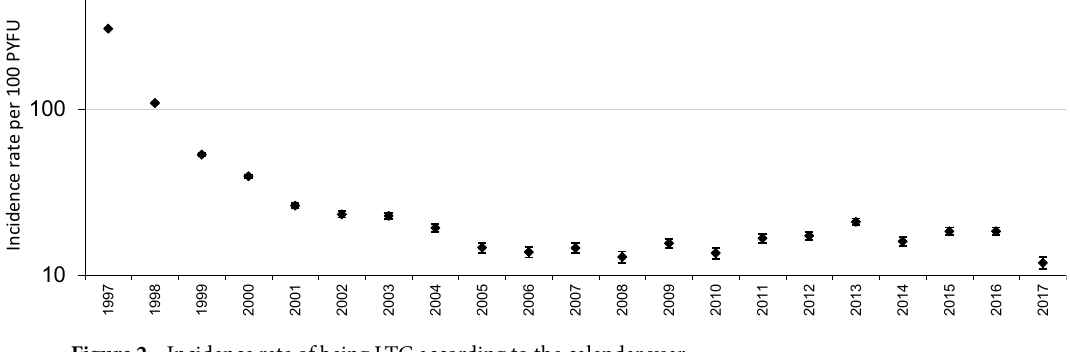
Figure 2. Incidence rate of being LTC according to the calendar